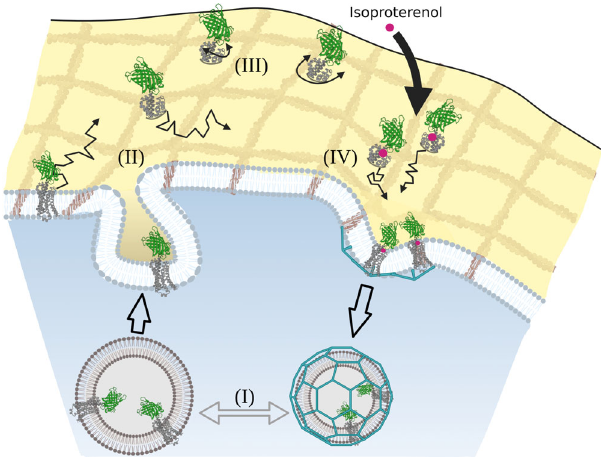
Fig. 6 Revised model of β 2 -AR dynamics. Schematic of cellular cross- section indicating the mobility spectrum of fl uorescently labeled β 2 -ARs. (I) Fast translational diffusion originating from vesicle transport close to the membrane. (II) Slower “ classic ” β 2 -AR membrane translational diffusion. (III) Rotational membrane diffusion of β 2 -AR. (II) and (III) occur simultaneously in all receptors; here illustrated separately for simplicity. (IV) Decreased “ classic ” β 2 -AR membrane translational diffusion upon activation by ligand binding (here: isoproterenol in magenta). The graphic was created with